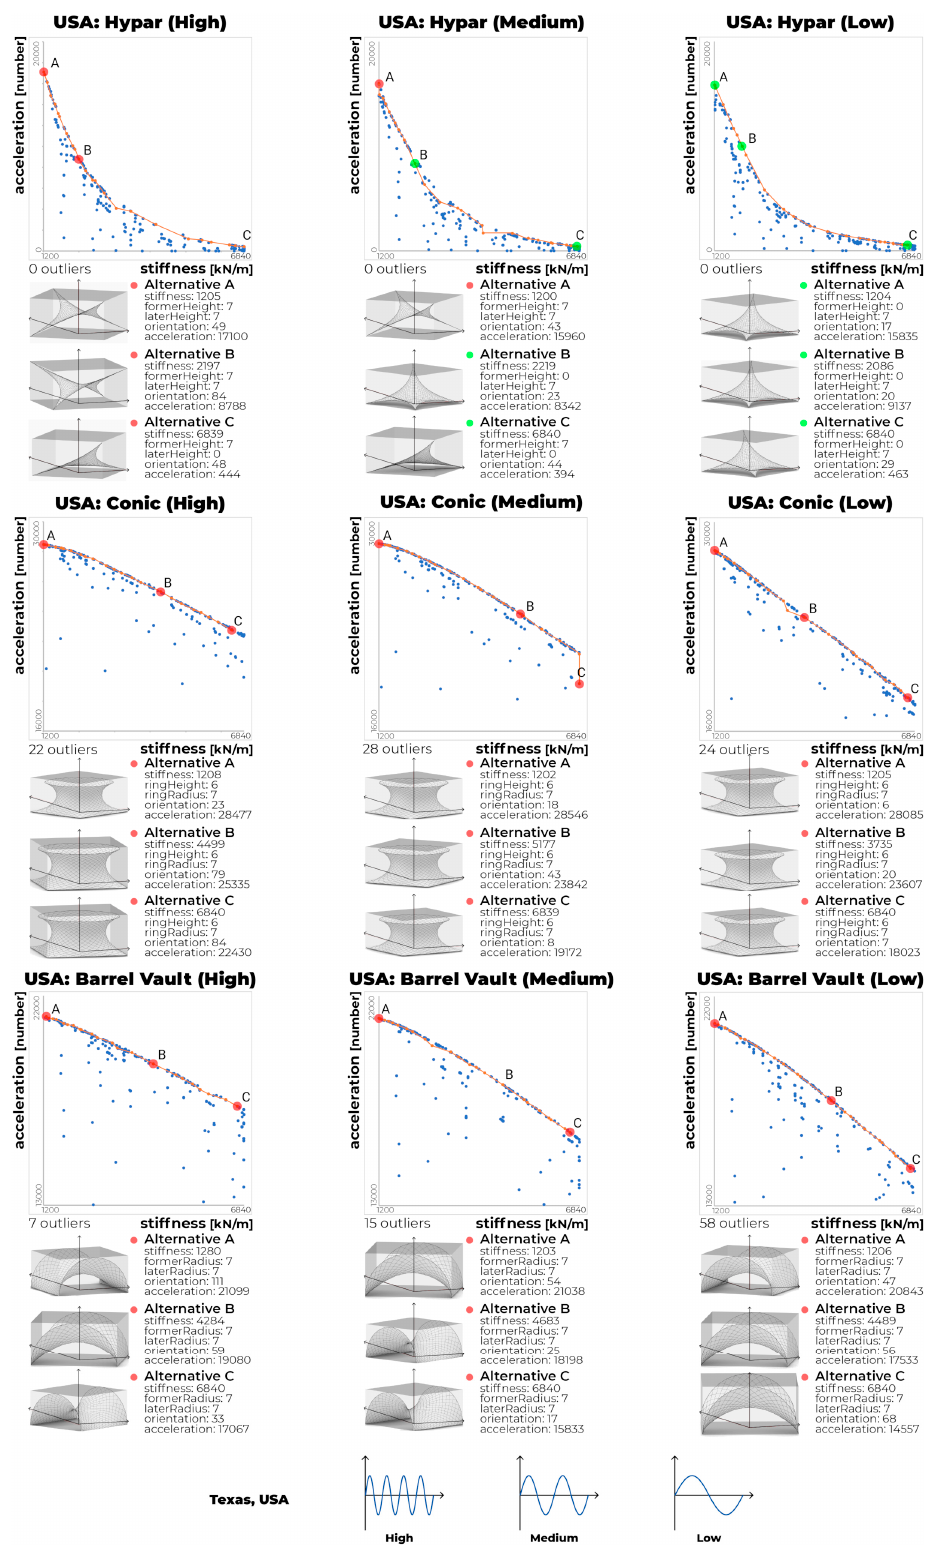
Figure 5. Pareto-optimization results for Texas, USA.